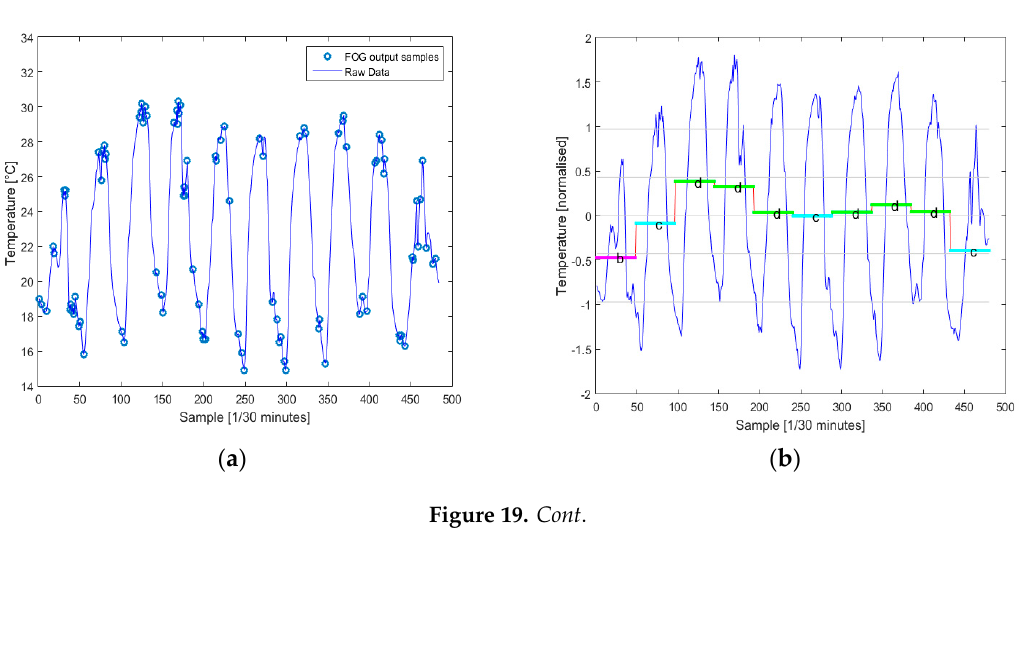
Table 2. Resulting Symbolic Aggregate Approximation (SAX) strings on consensus data.